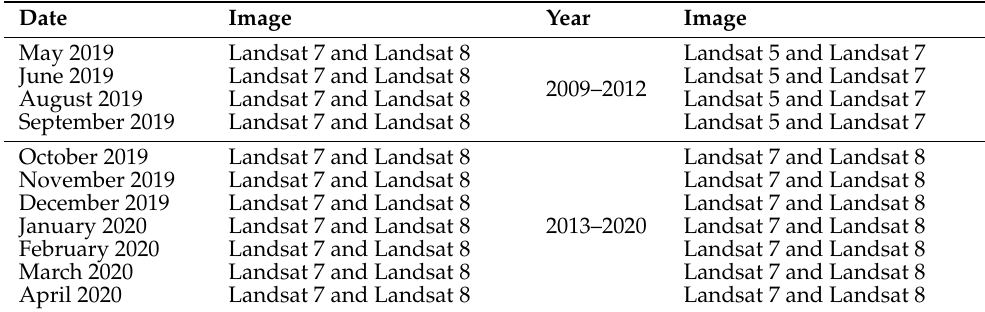
Table 1. Landsat data (Path:129, Row:43) used in this study a .